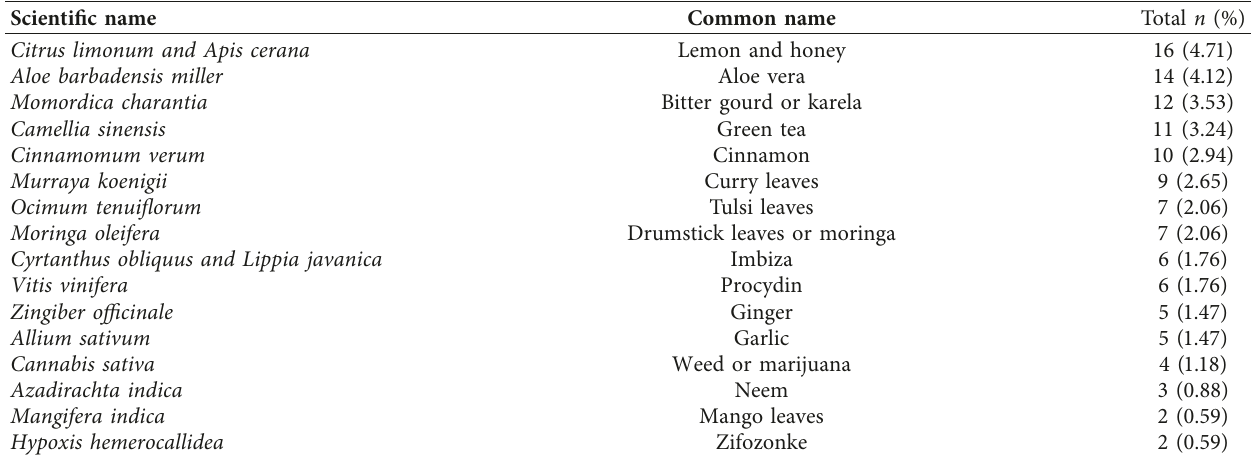
Table 4: Common home remedies used by study population ( N �